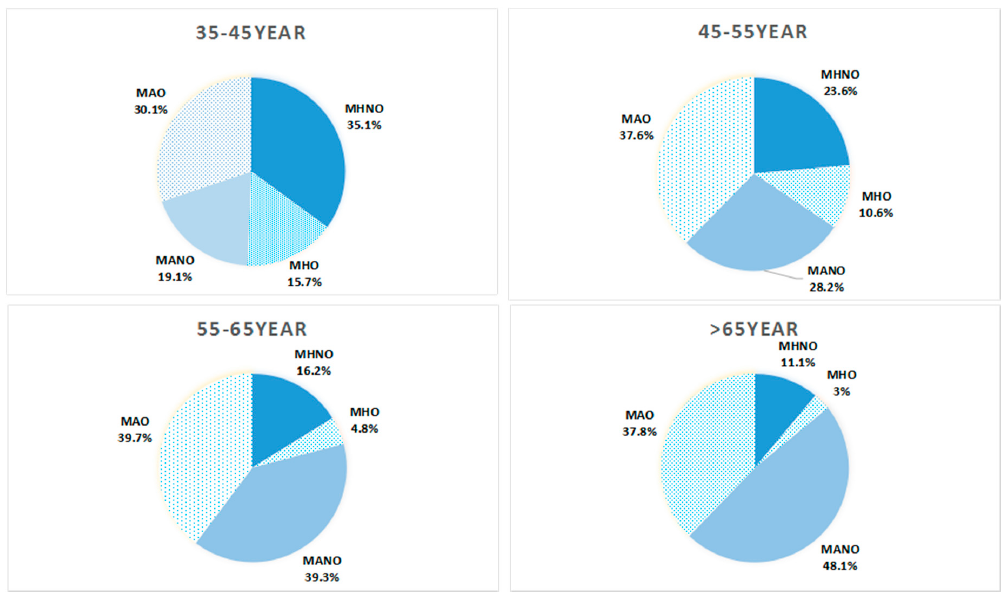
Figure 2. Prevalence of different obese phenotypes among rural Chinese resident by different genders.